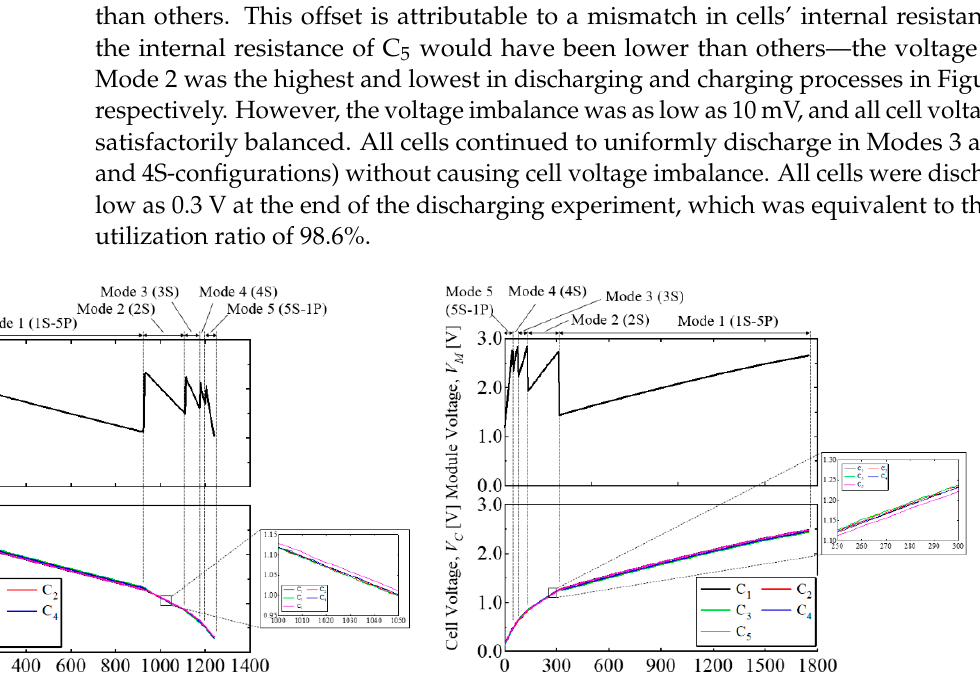
Figure 14. Resultant module and cell voltage profiles in ( a ) discharging and ( b ) charging processes.